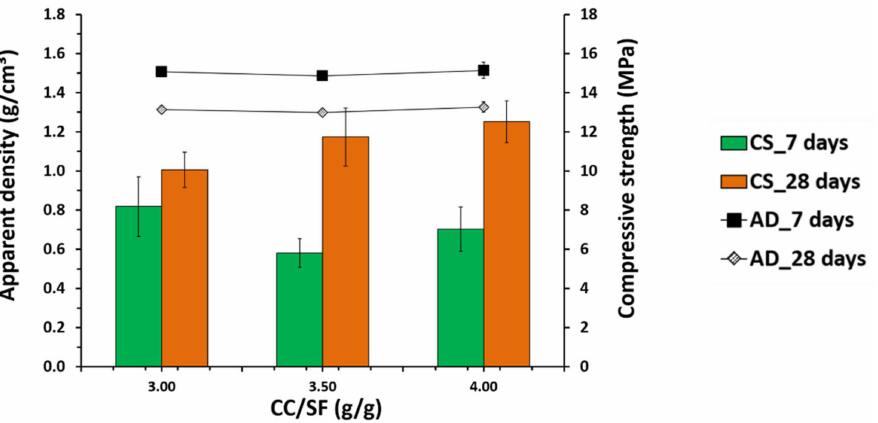
Figure 4. The apparent density and compressive strength of the alkali activated binders at 7 and 28 days of curing as a function of the calcined clay-to-silica fume mass ratio (CC/SF